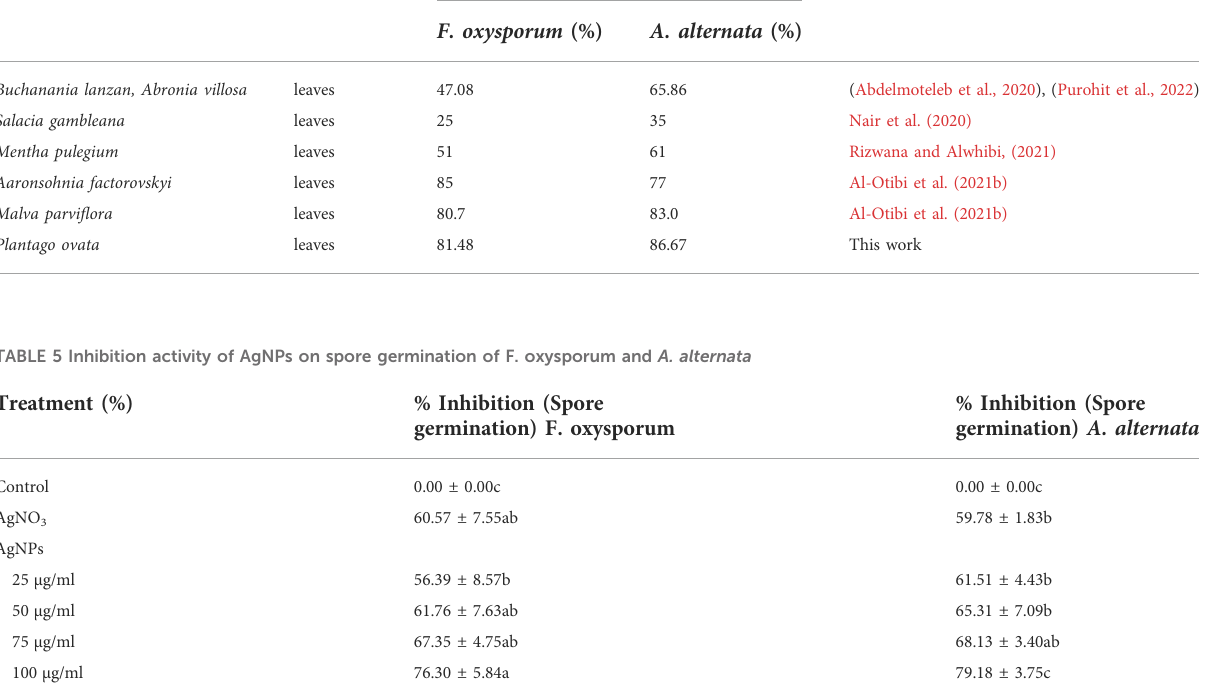
TABLE 4 Previous study of mycelial growth inhibition activity of synthesized AgNPs. Plants